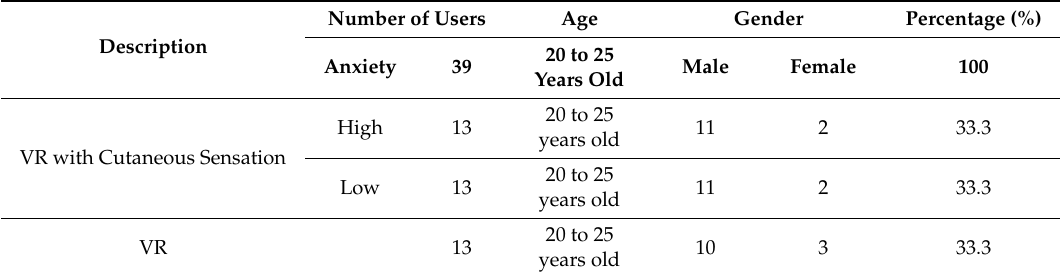
Table 3. User profile breakdown (For high- or low-anxiety groups, they are grouped by the mean of measuring